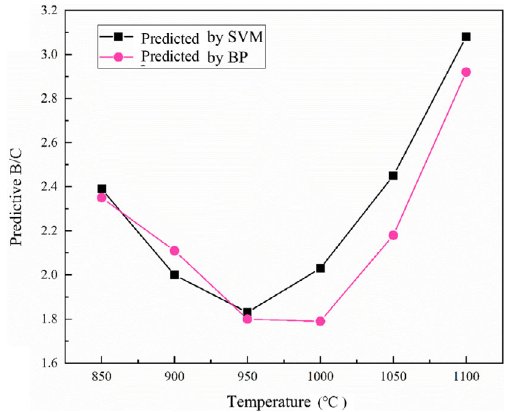
Fig. 10 Plots of the B/C ratios with deposition temperature, total pressure is 12 kPa, total gas flow rate is 210 sccm, In_BCl 3 is 2/7, and In_CH 4 is 1/7.